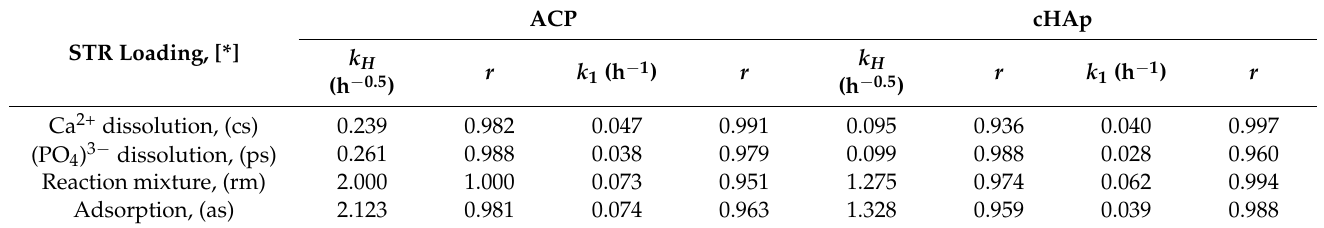
Figure 6. STR release profiles in PBS for ACP ( a ) and cHAp ( b ) nanoparticles loaded with STR according to the different studied methods. Table 3. Release kinetic parameters for ACP and cHAp nanoparticles loaded with STR. [*] indicates the loading path of the drug in the